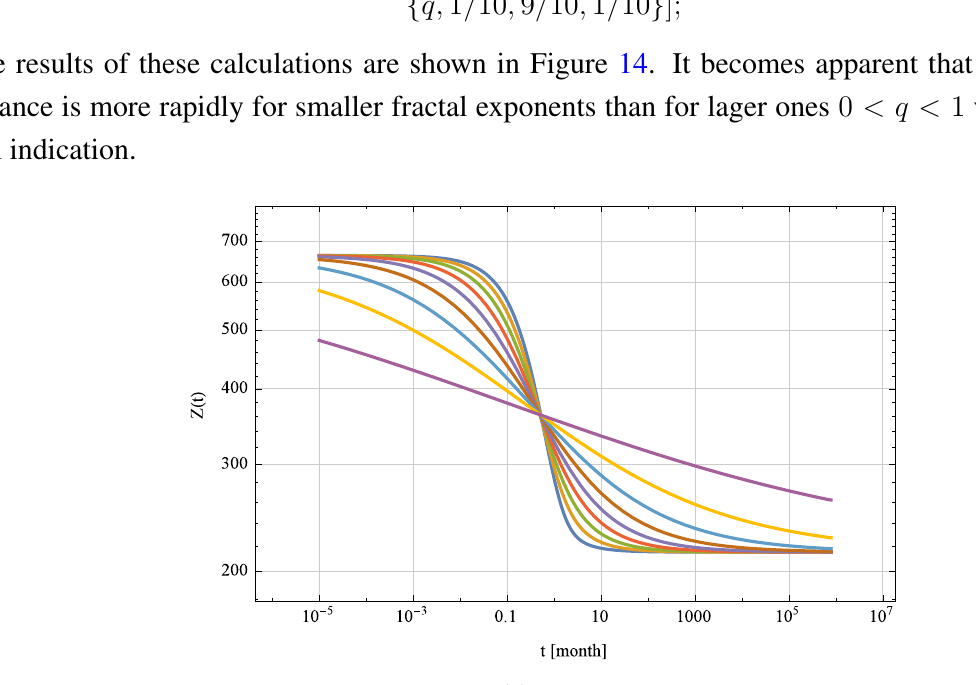
. The steepest transition i =1